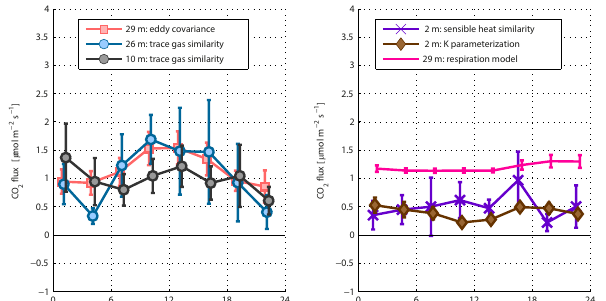
Figure 9. Comparison of wintertime (1–14 February 2012) CO 2 fluxes determined by eddy covariance, K parameterization, trace gas similarity (corrected; Sect. 4.2), sensible heat similarity, and respiration model throughout the forest canopy in the winter. Data points represent 3h aggregate mean and 95% confidence intervals.